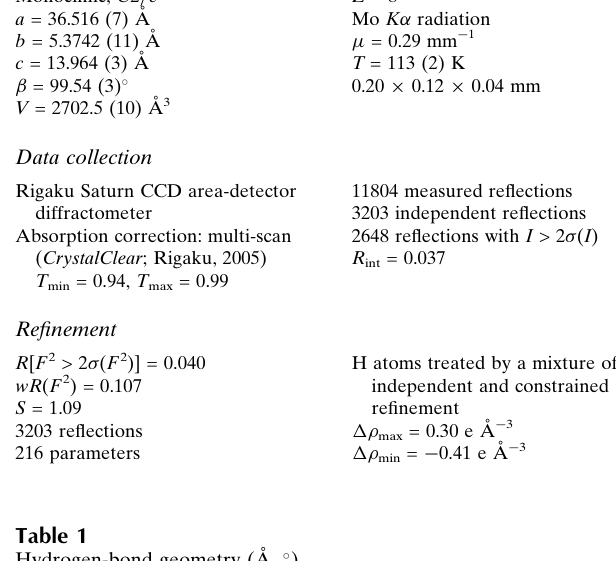
Rigaku Saturn CCD area-detector diffractometer Absorption correction: multi-scan ( CrystalClear ; Rigaku, 2005)